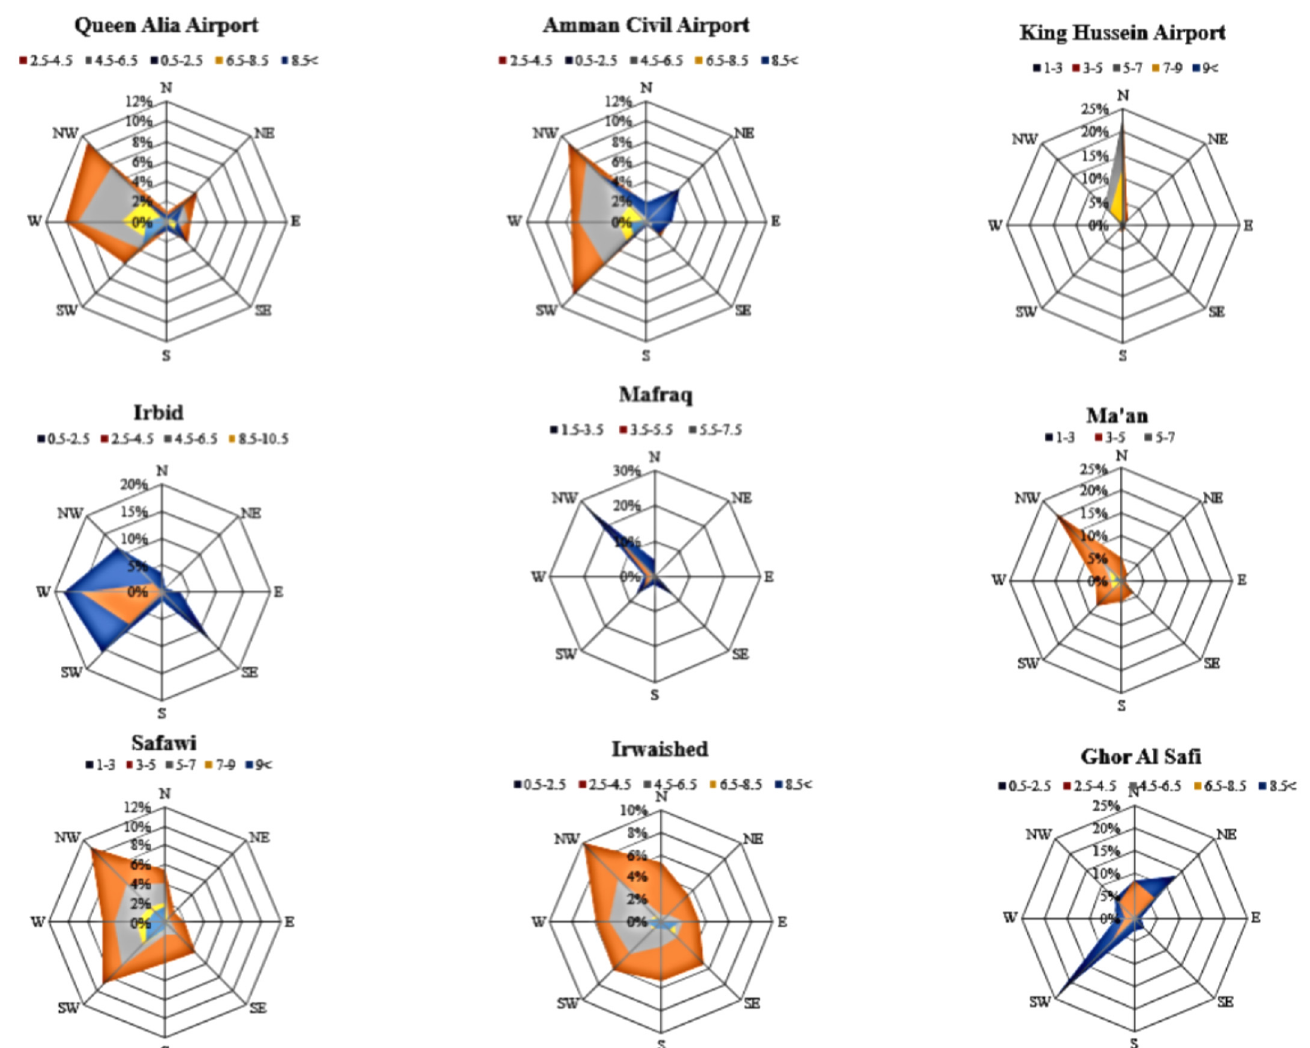
Figure 2. Wind rose of the selected wind